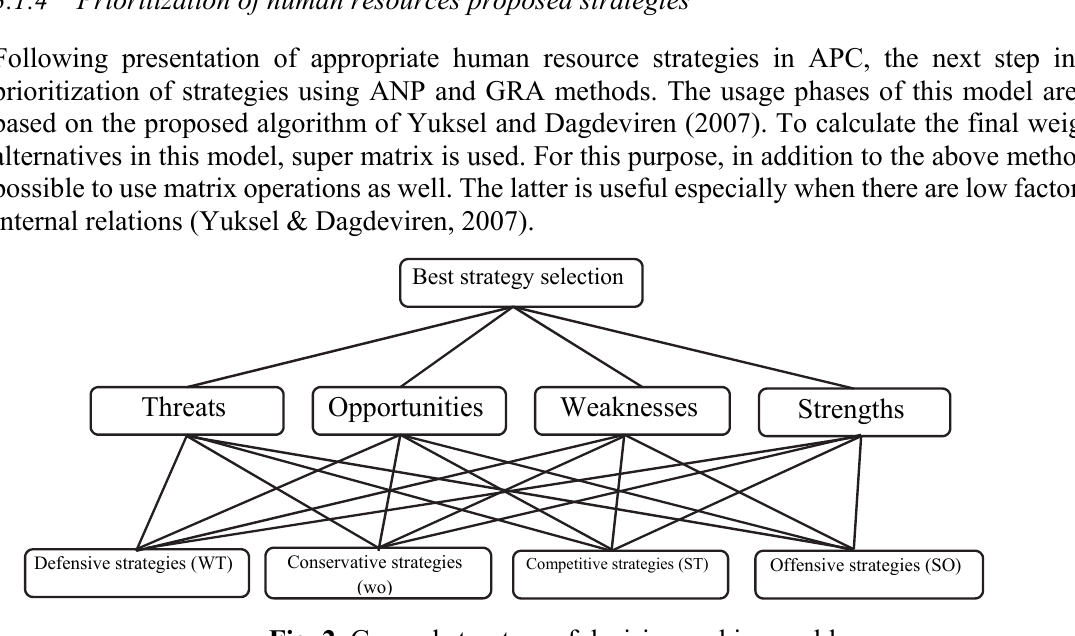
Fig. 2. General structure of decision making